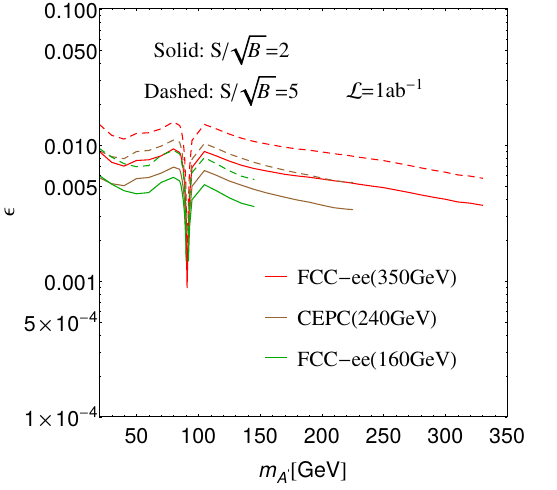
Figure 4 . Sensitivities to (cid:15) at the FCC-ee (160 GeV), CEPC (240 GeV) and FCC-ee (350 GeV) with the same integrated luminosity L = 1 ab (cid:0) 1